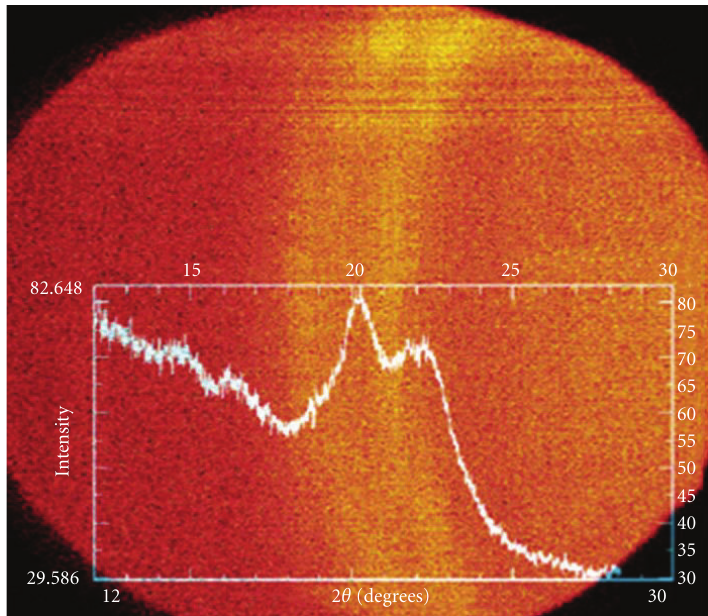
Figure 5: X-ray pattern to demonstrate the crystallinity of soybean stock nanofibers [31].